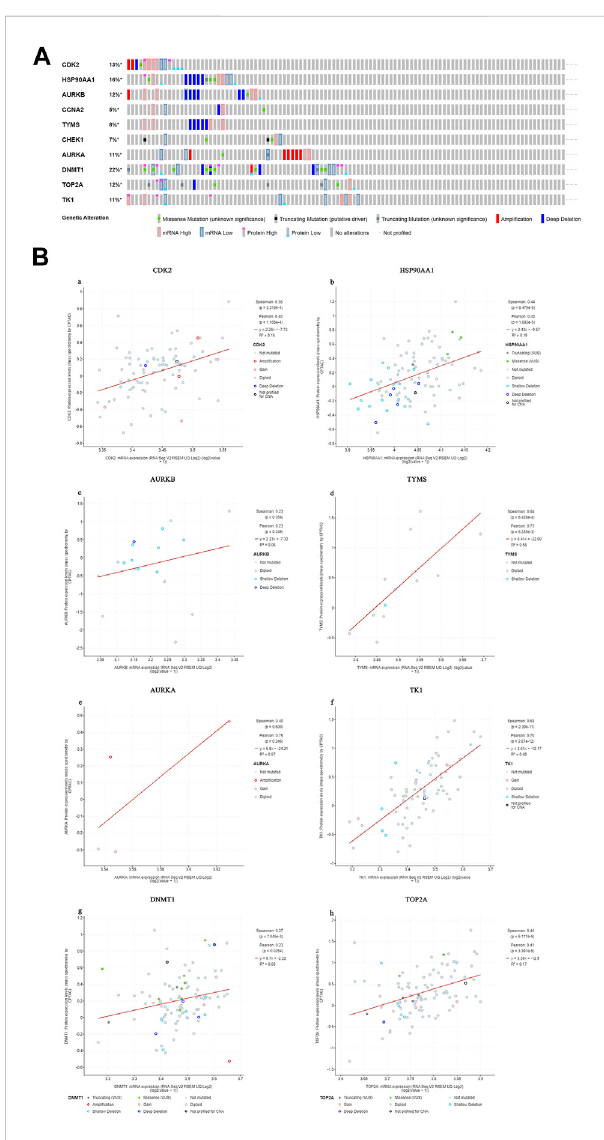
FIGURE 10 Genetic information of hub targets. ( (A) . Data showed that 57 of 110 patients (52%) had genetic mutations in these targets. (B) . The diagram shows the correlation between the mRNA and protein levels of (a) CDK2, (b) HSP90AA1, (c) AURKB, (d) TYMS, (e) AURKA, (f) TK1, (g) DNMT1, (h) TOP2A).